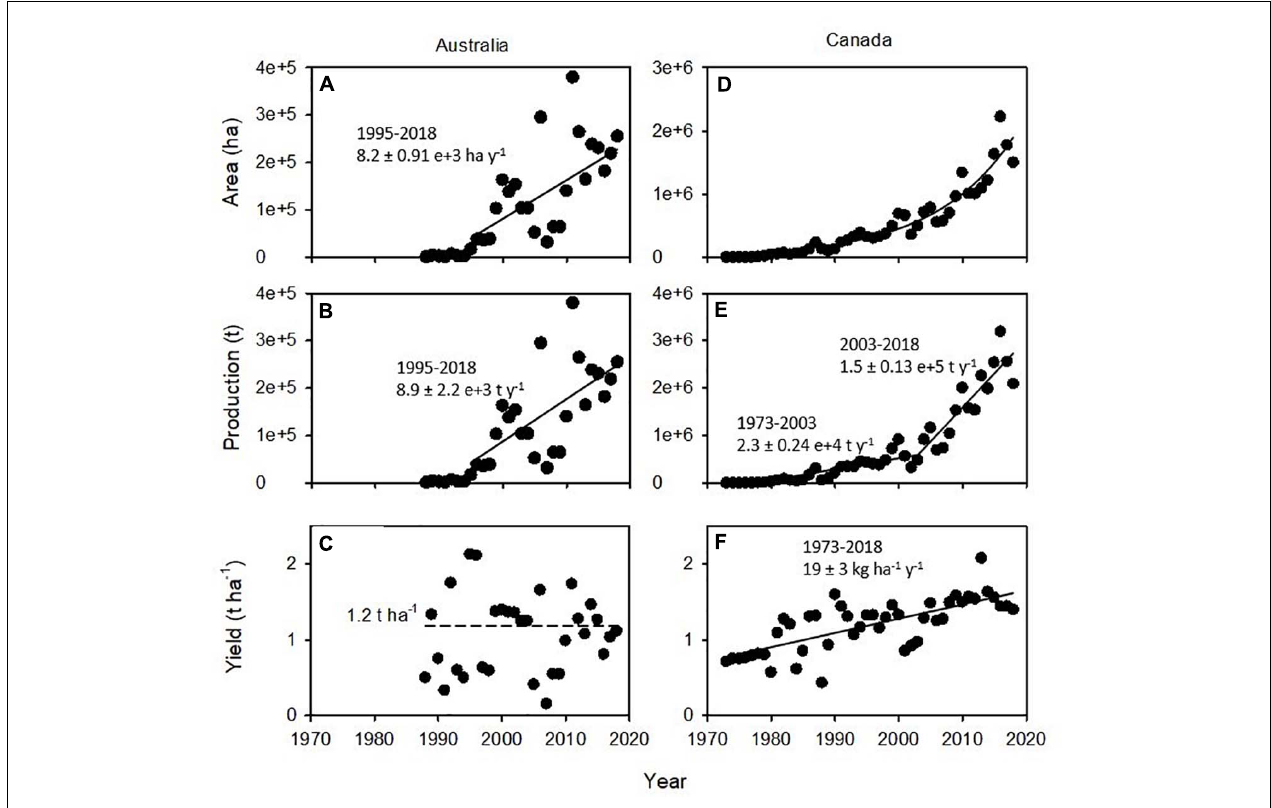
FIGURE 1 | Area, production, and yield of lentils in (A–C) Australia and (D–F) Canada. In (A,B,E,F) , slopes and standard errors are shown for the fitted least-square regressions. In (A,B,E) , inflection points were identified fitting piece-wise models. Note difference in scales between Australia and Canada for area and